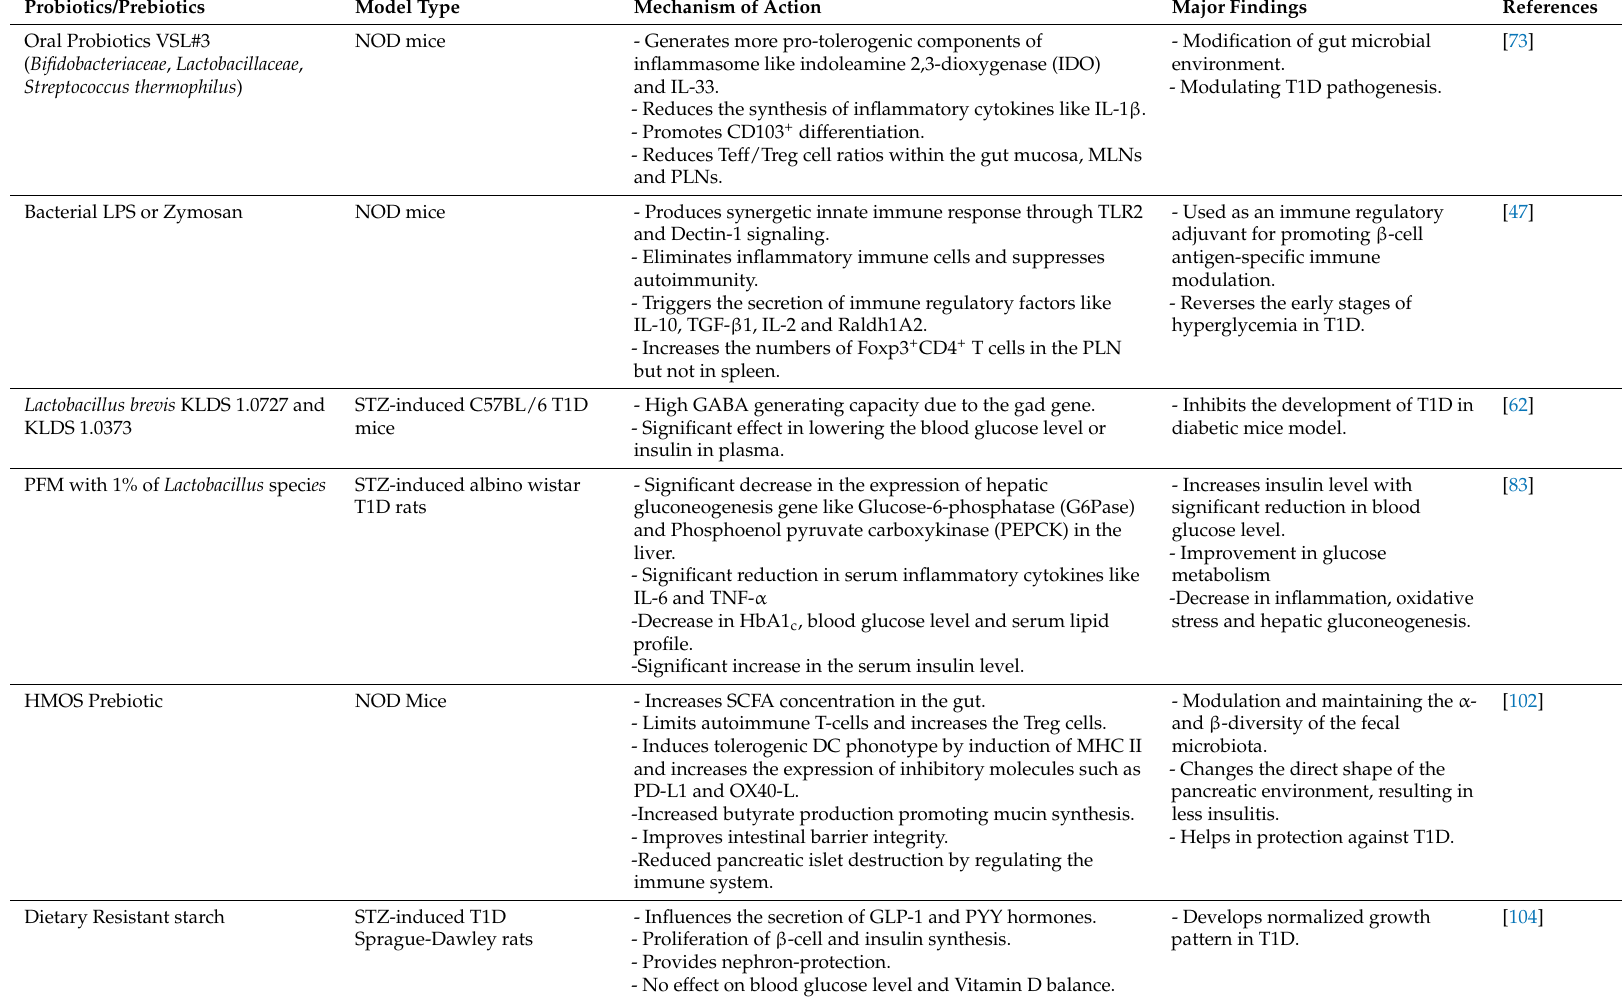
Table 1. Summary of major animal studies of probiotic and prebiotic interventions and their findings related to T1D-associated features and